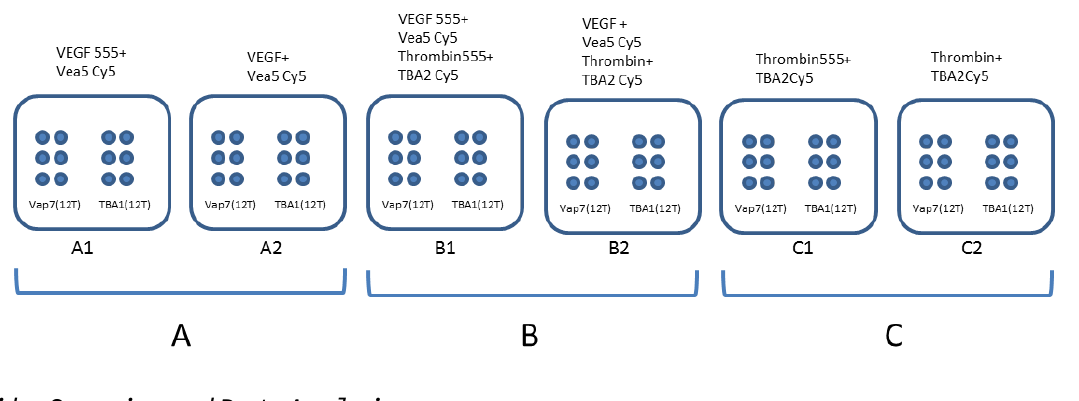
Figure 1. Scheme of the microarray printed glass slide. A1: detection of VEGF555; A2: detection of VEGF. B1: detection of VEGF555 mixed with thrombin555; B2: detection of VEGF mixed with thrombin. C1: detection of thrombin555; C2: detection of